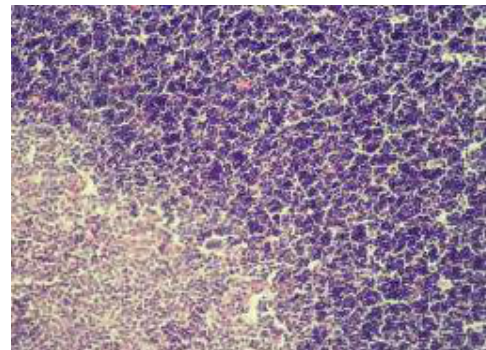
Fig. 1. Piglet thymus, the 1 st group, the 70 nd day of test. Division into cortical portion and medullary portion is preserved. H&E. x